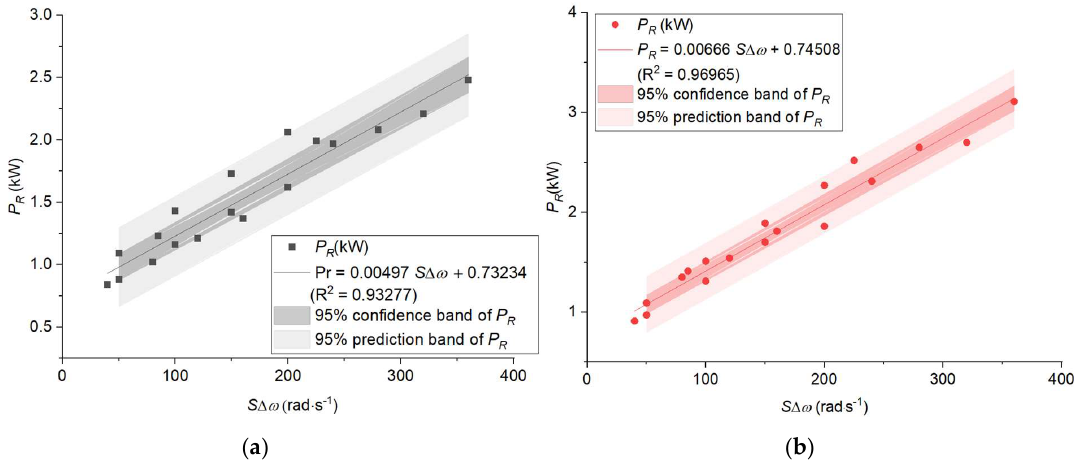
Figure 5. Power consumption for grinding as a function of total speed increase; marking the confidence interval and values predicted for ( a ) rice grinding and ( b ) corn grinding. Table 4. Test results of significance of the coefficients of the linear regression model of power consumption.